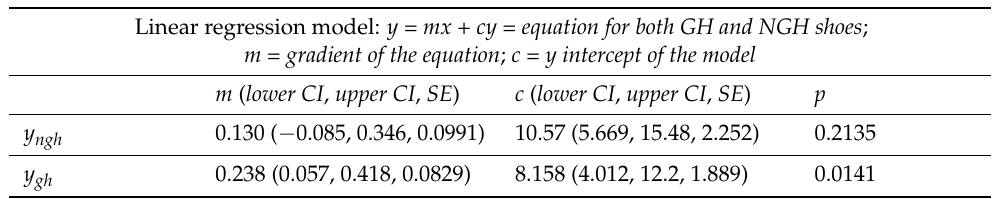
Table 2. Linear Regression—Statistical Analysis for Capacitance and Foot-Length Relationship. Linear regression model: y = mx + cy = equation for both GH and NGH shoes ; m = gradient of the equation ; c = y intercept of the